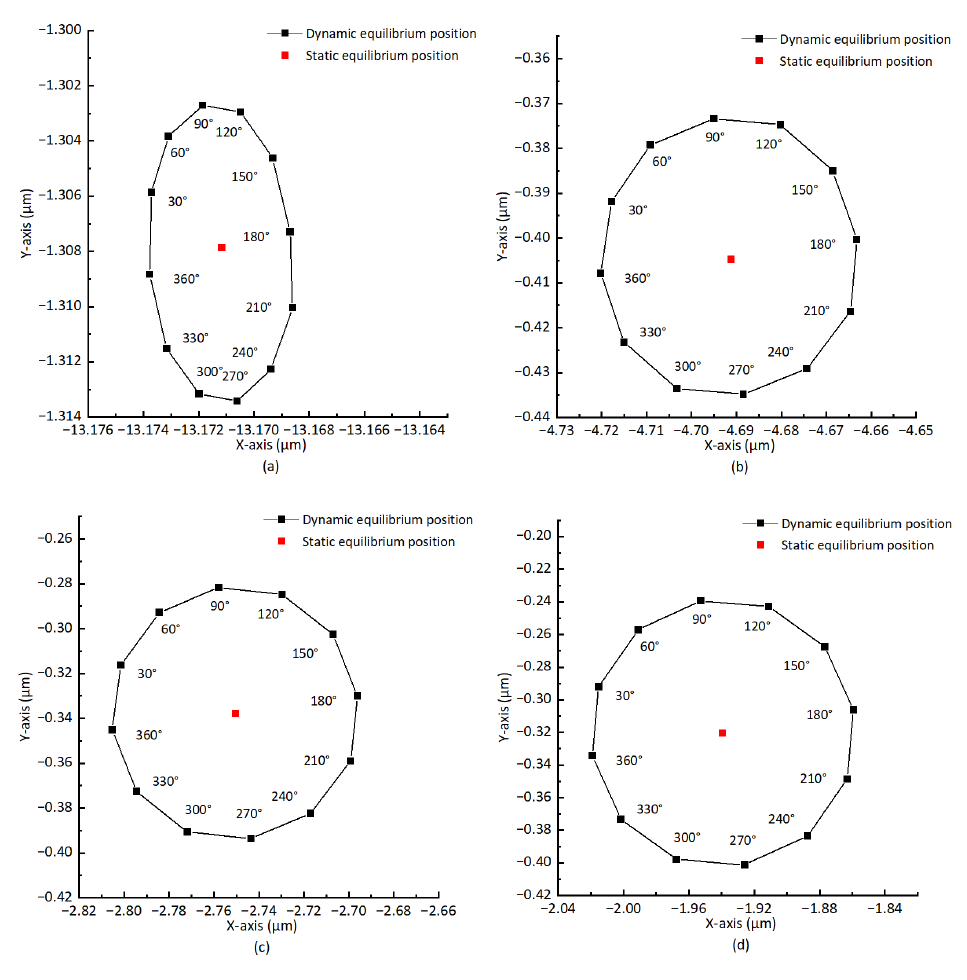
Figure 11. Static and dynamic equilibrium positions at different rotating speeds. ( a ) n = 1000